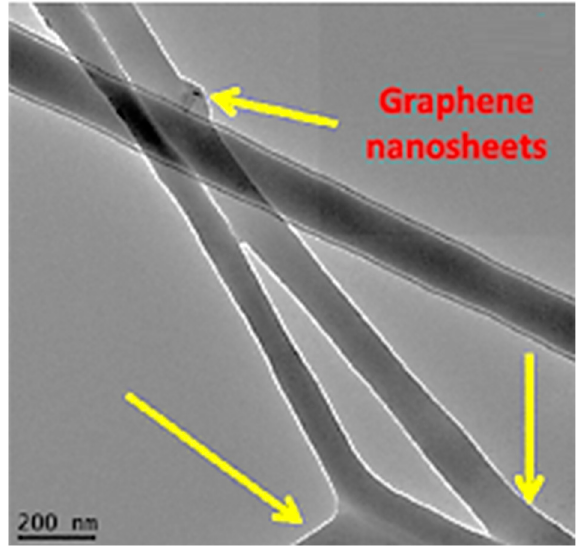
Figure 4. TEM image of 0.15 wt.% graphene-loaded chitosan/gelatin nanofibers [90]. Reproduced with permission from Reference [90]. Copyright 2022 American Chemical Society.